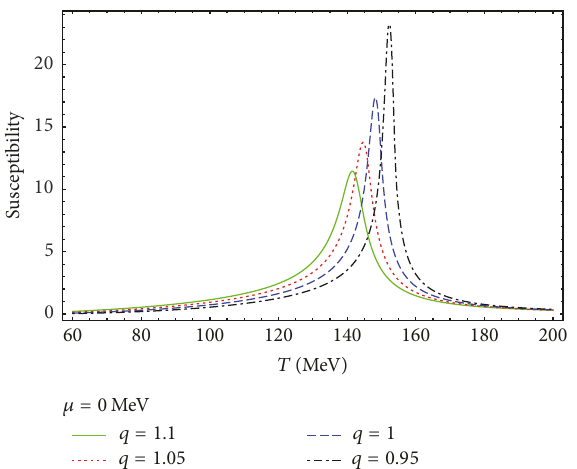
Figure 3: The nonextensive effects on susceptibility 𝜒 = −(𝜕𝑀/𝜕𝑇)| 𝜇 with temperature 𝑇 at 𝜇 = 0 are shown for various 𝑞 values as shown in previous figures ( q = 1.1, q = 1.05, and q = 0.95 as well as q = 1 for baseline).